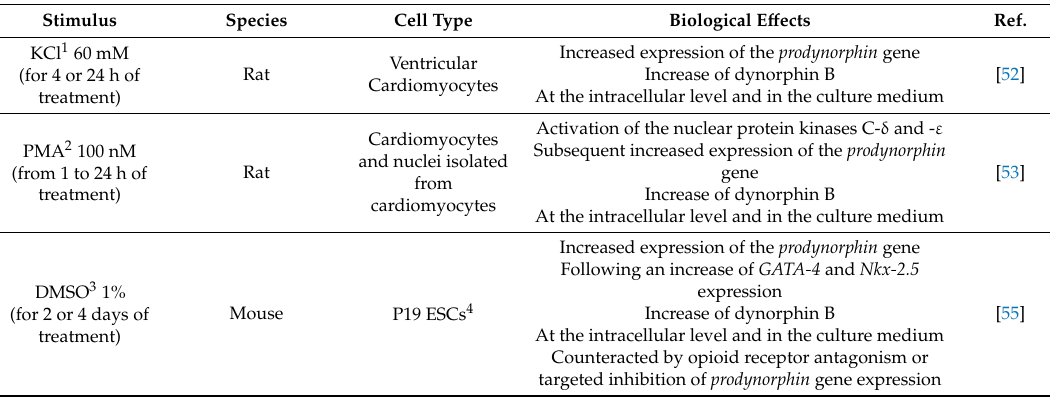
Table 1. E ff ects of di ff erent agents on cardiac function and